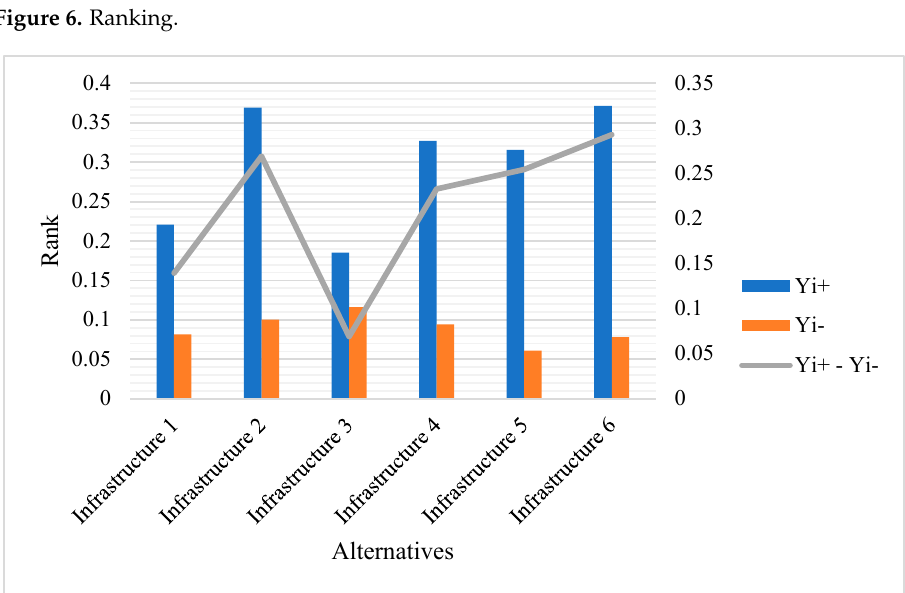
Figure 6. Ranking.